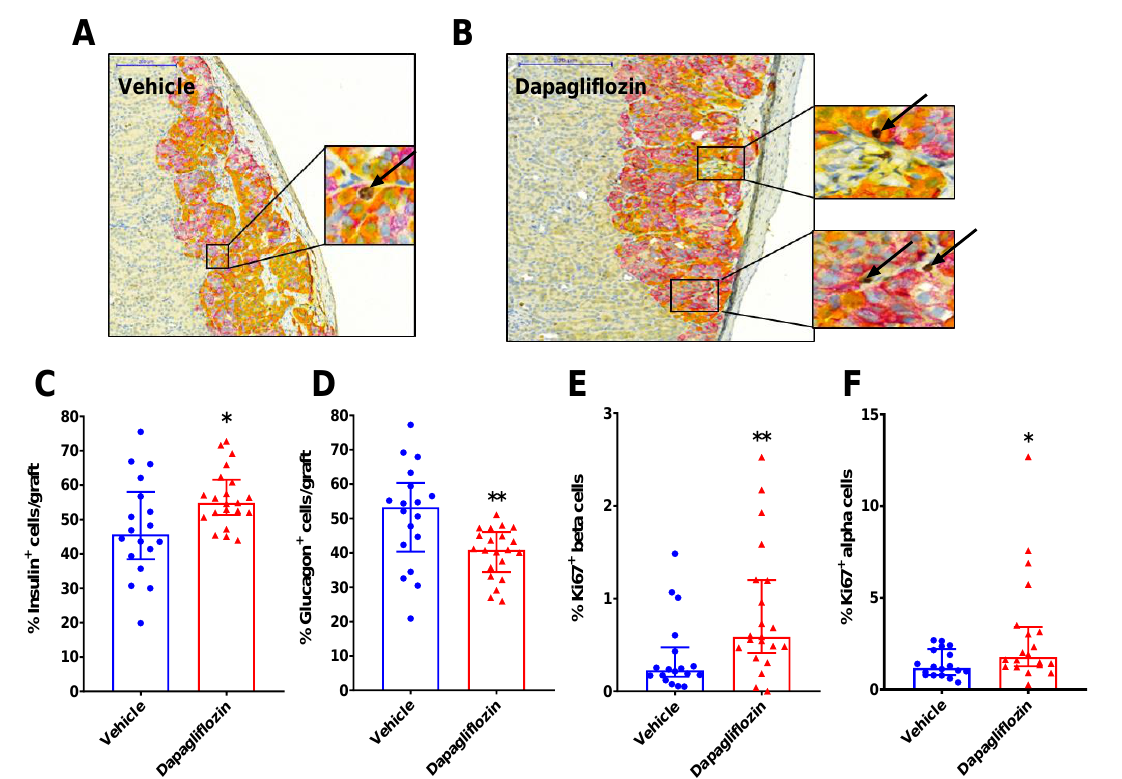
Figure 3. Dapagliflozin increased both alpha and beta cell proliferation. Triple staining of human islets grafted under the kidney capsule showing an example from ( A ) vehicle and ( B ) dapagliflozin-treated mice. Insulin-positive cells are stained in purple, glucagon in yellow, and Ki67 in brown. The arrows indicate the brown Ki67-positive cells. ( C ) Quantification of the insulin-positive cells and ( D ) the positive glucagon cells in human islet grafts. The area of the graft was determined by a computerized model, and the number of insulin and glucagon-positive cells were counted. The analysis also determined the percentage of proliferating beta cells ( E ) insulin + and Ki67 + dual-positive cells and alpha cells ( F ) glucagon + and Ki67 + dual-positive cells in the grafts. The data are presented as median with error bars representing the interquartile range. Statistical differences were determined with Mann–Whitney’s non-parametric test. * p < 0.05, ** p < 0.01. Number of samples were n = 21 (dapagliflozin, red symbols) and n = 17 (vehicle, blue symbols).